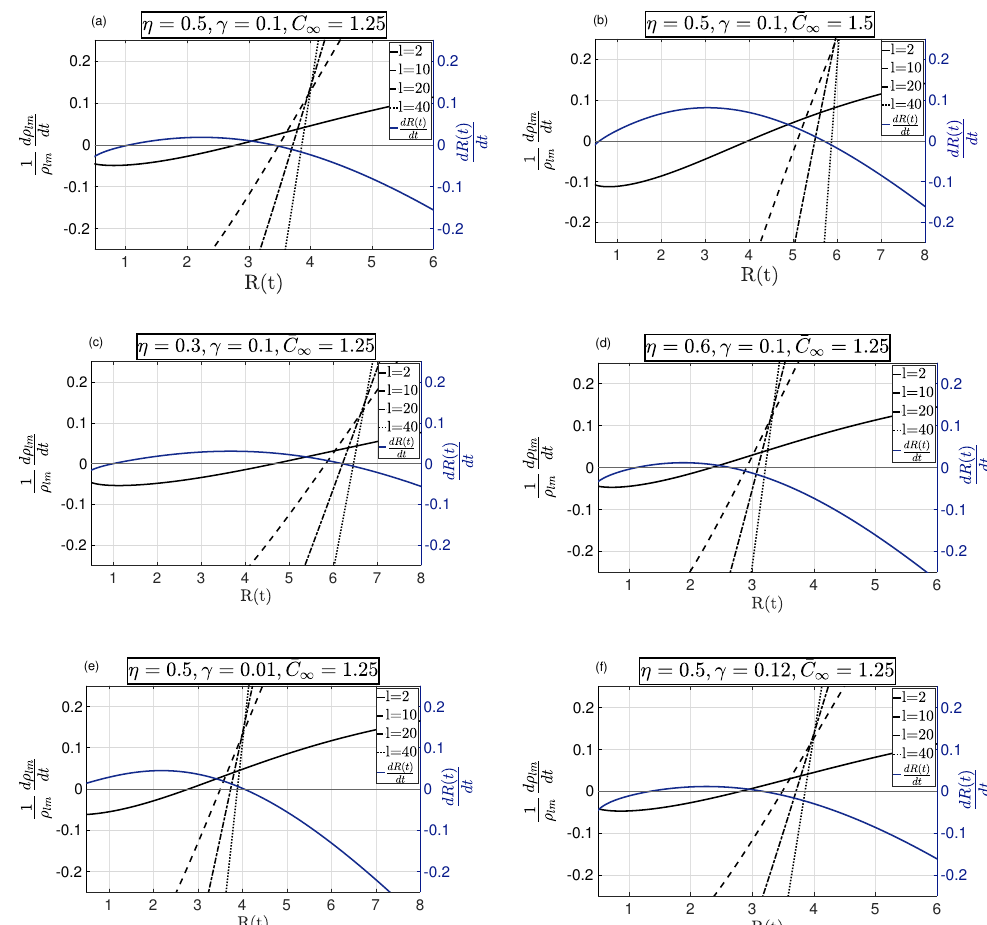
( θ , φ ) with respect to R ( t ) for four choices of mode Figure 2. Growth rate of asymmetric modes Y m l = 0 indicate the number l = { 2,10,20,40 } . In each sub-figure, the radii where the curves cross dR dt steady-state solutions, i.e., R 1 < R 2 . In ( a ) ¯ C ∞ = 1.25 and ( b ) ¯ C ∞ = 1.5; the number of unstable asymmetric modes for R 2 was reduced by lowering the nutrient source ¯ C ∞ . For instance, for l = 20, the steady state was unstable in ( b ), while reducing ¯ C ∞ stabilized it in ( a ). In ( c ) η = 0.3 and ( d ) η = 0.6; a higher rate of consumption led to smaller steady-state R 2 with a smaller number of unstable asymmetric modes. In ( e ) γ = 0.01 and ( f ) γ = 0.12; reducing the surface tension allowed for larger steady-state R 2 , while more asymmetric modes became unstable. In all cases, R 2 was unstable to low-mode numbers, but was stable with respect to sufficiently large mode